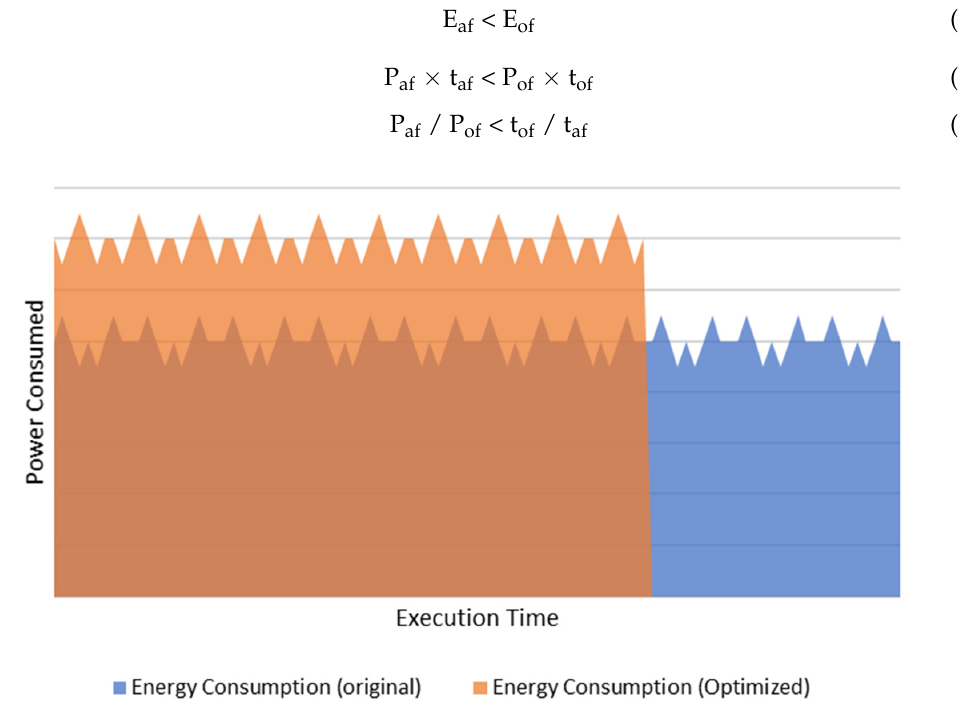
Figure 1. Schematic diagram of the energy consumption before and after adjusting the processor clock frequency.